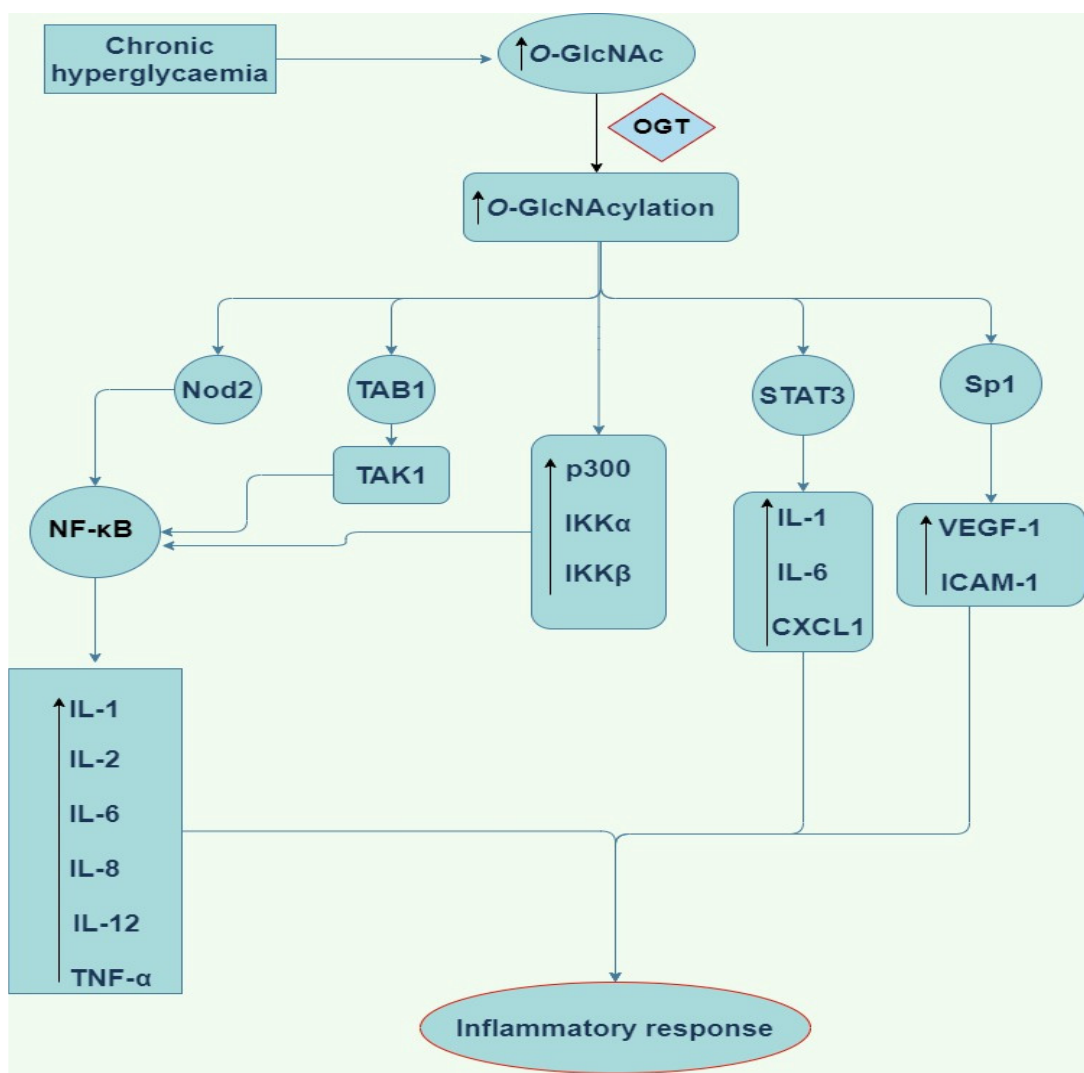
Figure 3. Schematic of the pro-inflammatory downstream signalling modulation by O- GlcNAcyla- tion. O -GlcNAc ( O -linked β - N -acetylglucosamine), OGT ( O -linked β - N -acetylglucosamine transferase), NF- κ B (nuclear factor kappa light chain enhancer of activated B cells), STAT3 (signal transducer and activator of transcription3), TAK 1 (Transforming growth factor- β activated kinase 1), TAB1 (TAK1-binding protein 1), Nod2 (nucleotide-binding oligomerization domain-containing protein 2), IL-1,6,8, and 12 (Interleukin-1,6,8, and 12), Sp1 (substrate of Keap1), CXCL1 (chemokine ligand 1), VEGF-A (vascular endothelial growth factor), ICAM-1 (intercellular Adhesion Molecule 1), TNF- α (tumor necrosis factor alpha).